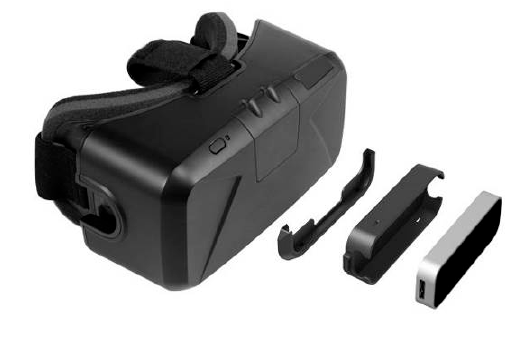
Figure 7. Oculus with Leap Motion (www.leapmotion.com)